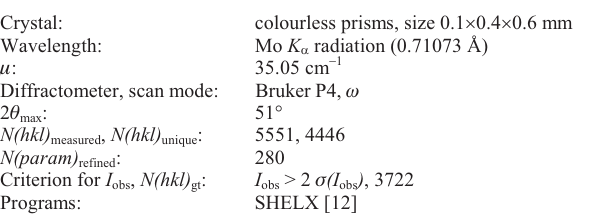
Table 1. Data collection and handling.